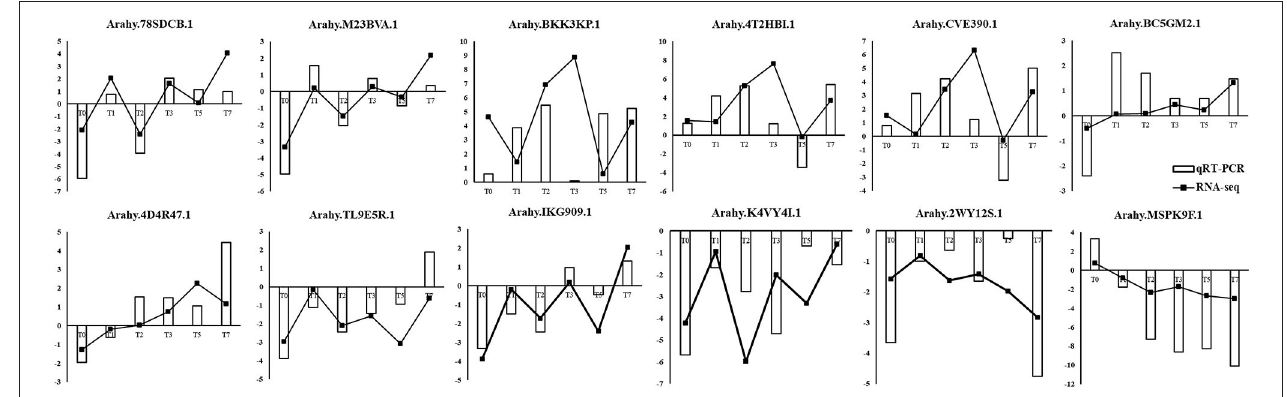
FIGURE 8 | Validation of RNA-seq data by RT-qPCR. Y-axis showed the log 2 (R/S) between R and S . Positive value indicated upregulated in R and negative value indicated downregulated in R